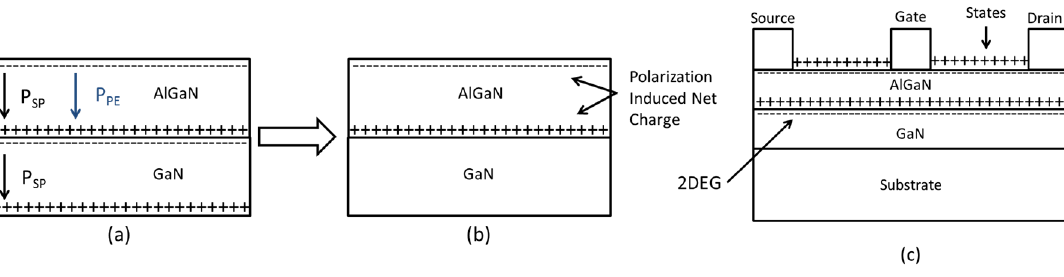
Figure 2. ( a ) Individual polarization charge contributions; ( b ) Polarization induced net charge; ( c ) the AlGaN/GaN HEMT with polarization induced net charge and surface